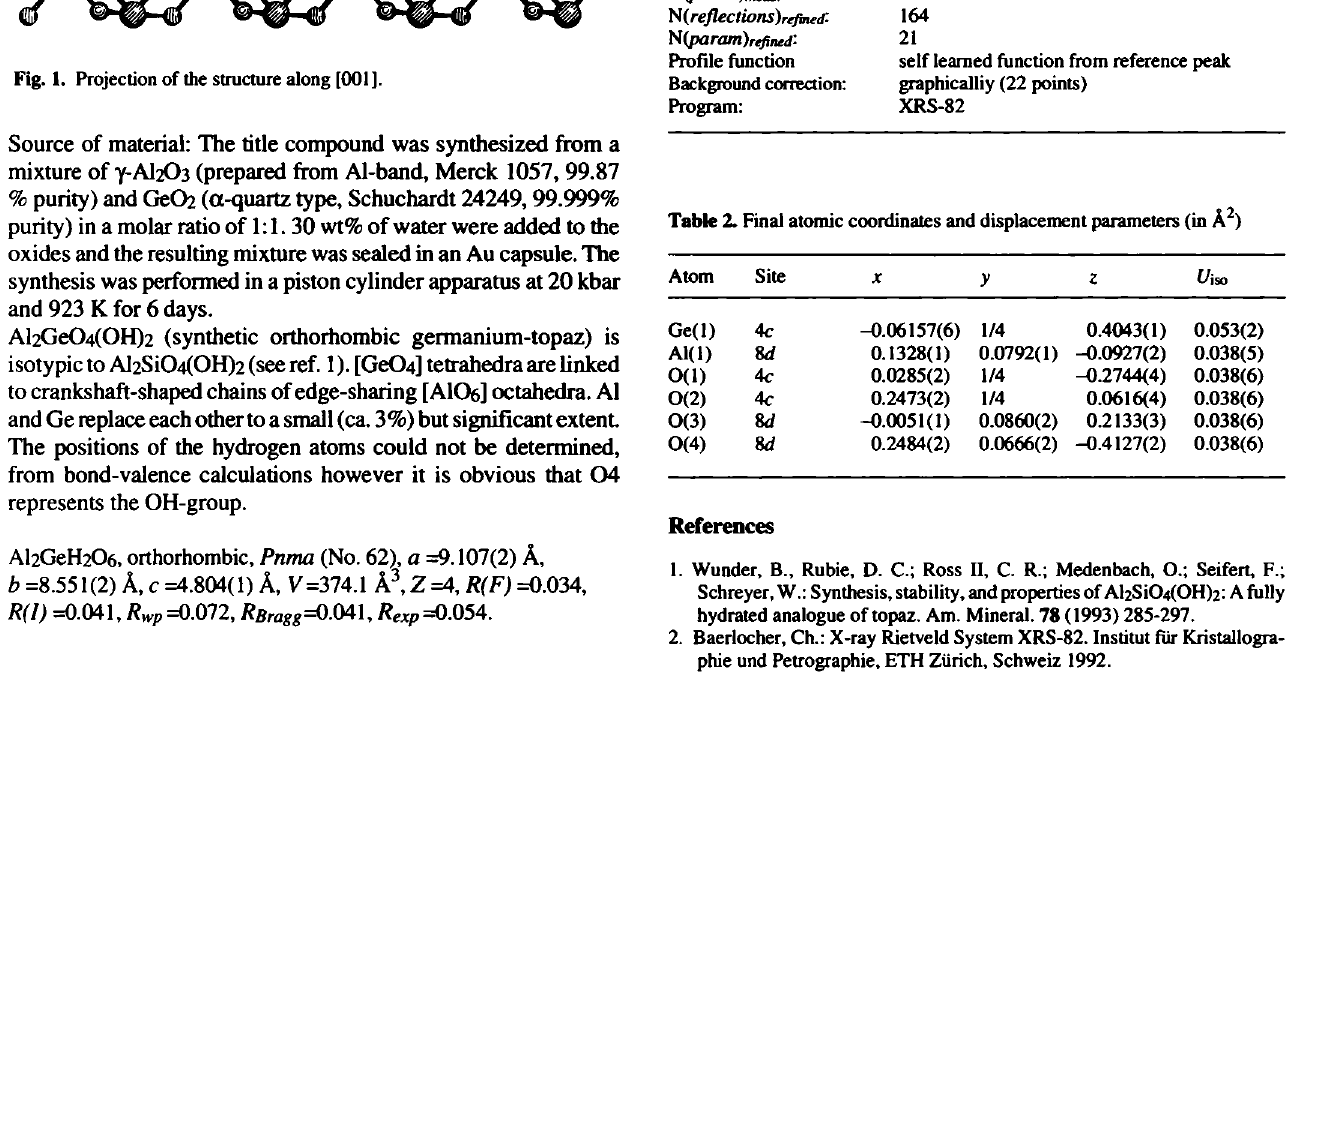
Table 1. Parameters used for the X-ray data collection